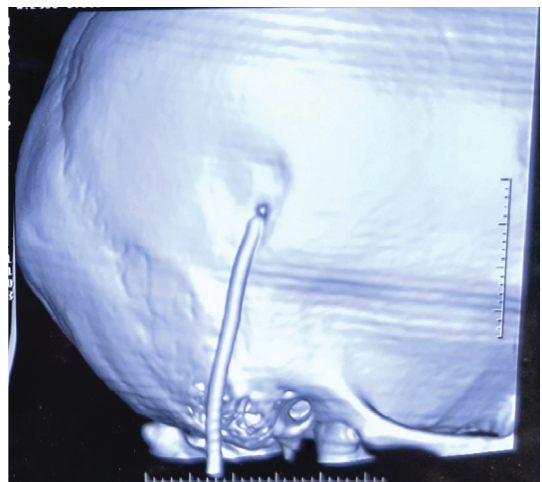
Figure 3: The 3-dimensional reconstructed image of CT scan showing VP shunt proximal end lying